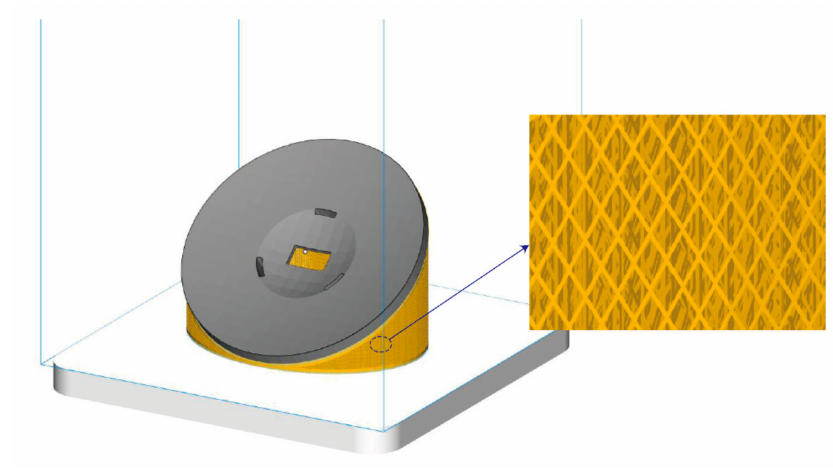
Figure 8. Visualization of support structures.